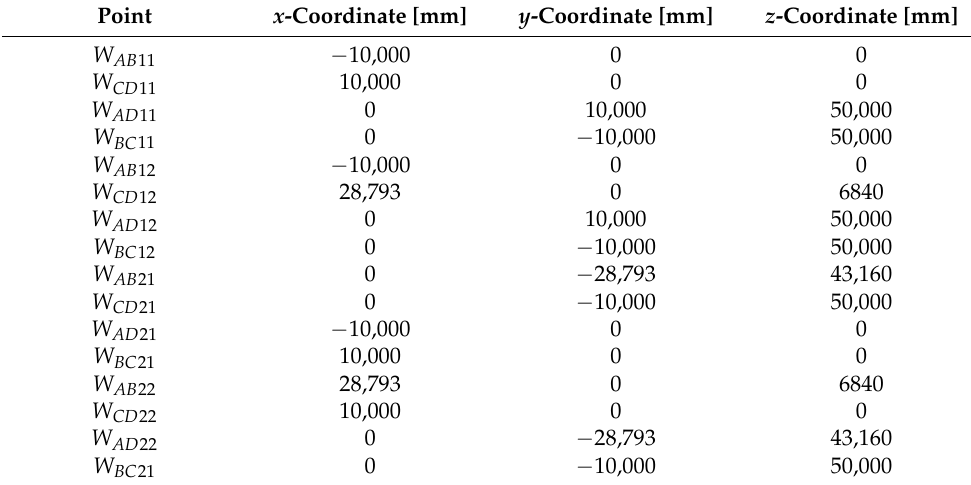
Table A1. The coordinates of the vertices W ABij , W CDij , W ADij , W BCij (for i , j = 1, 2) of the basic